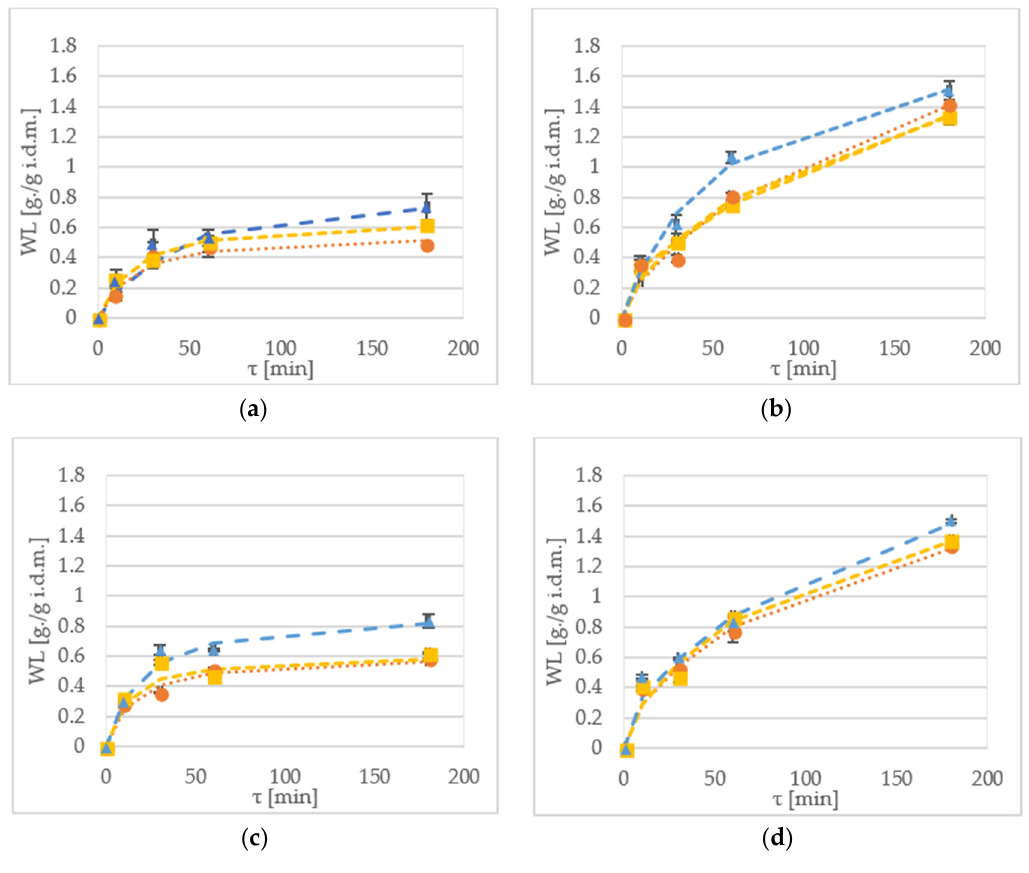
Figure 2. WL kinetics of the ‘Geneva’ cultivar dehydrated at ( a ) 30 °C; and ( b ) 50 °C in xylitol ( ▲ — triangle), maltitol ( ■ —square) and sucrose ( ● —circle). WL kinetics of the ‘Weiki’ cultivar dehydrated at ( c ) 30 °C; and ( d ) 50 °C in xylitol ( ▲ —triangle), maltitol ( ■ —square) and sucrose ( ● —circle). Dotted lines represent values obtained from the mathematical modelling. Table 3. Values of RMSE , χ 2 , R 2 and CRV of best fitting mathematical model of WR.